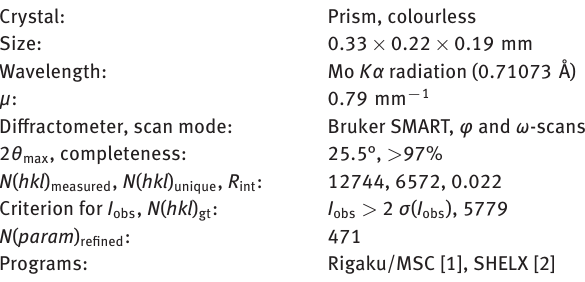
Table 1: Data collection and